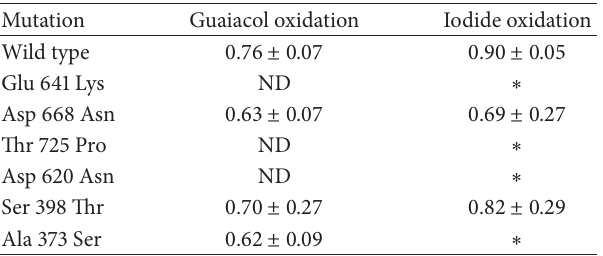
Table 5: Guaiacol and iodide oxidation activity of expressed human TPO